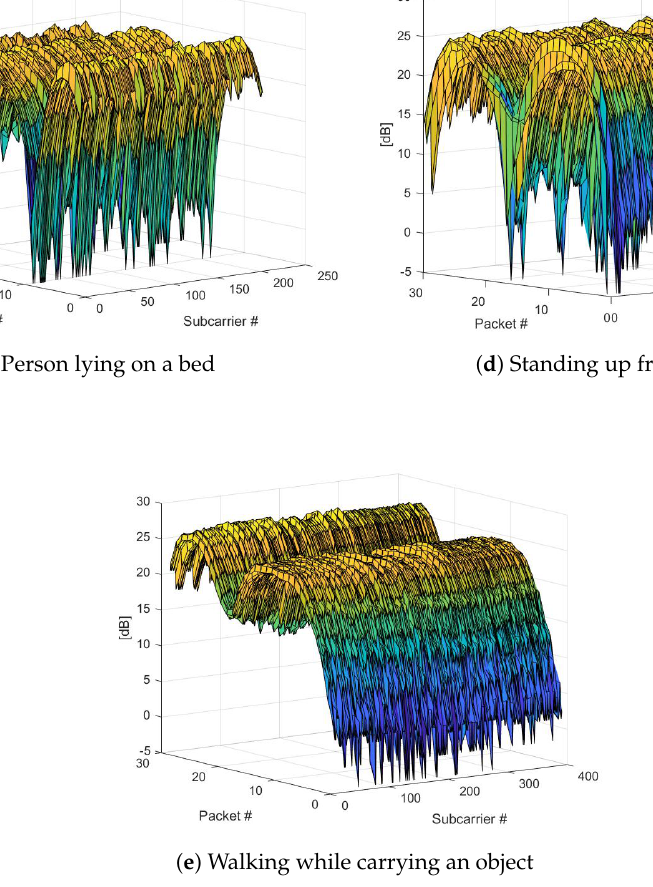
Figure 3. WiFi sensing data for different activities including lying on a bed for respiratory rate